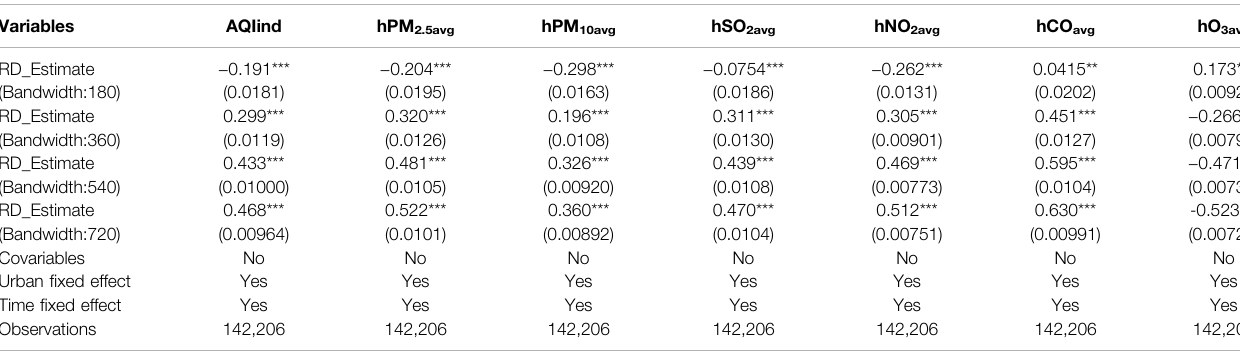
TABLE 8 | Persistence analysis of the